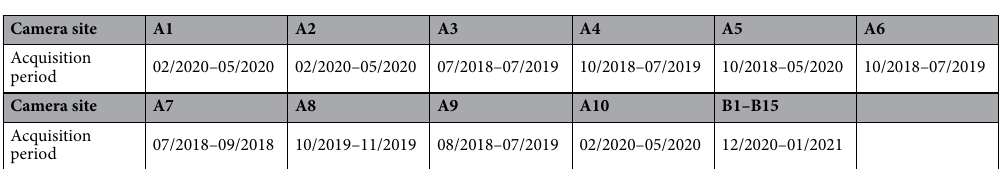
Table 1. Data acquisition period for each camera site included in the